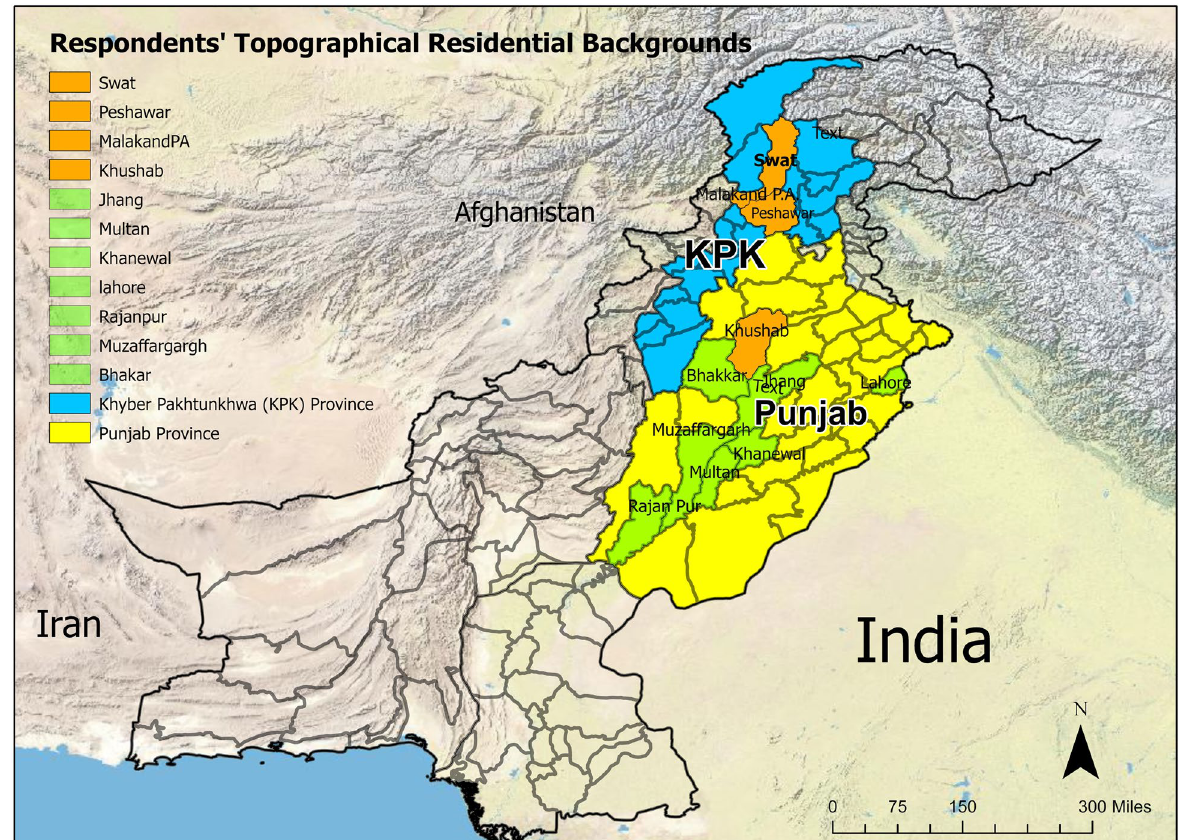
Fig. 1 Map of study districts in mountainous and plain topograhical backgrounds in Punjab and Khypber Pakthunkhwa province of Pakistan, A Cross-Sectional Survey on Fruit Bat-Human Interaction in Pakistan; One Health Perspective,